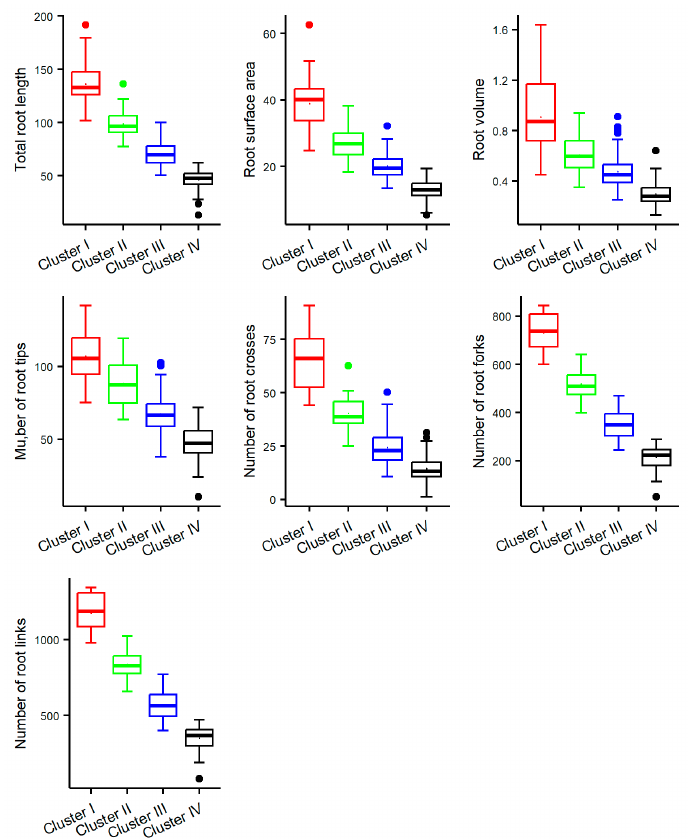
Figure 4. Boxplot for each of the variables with the average and standard difference of error values for each bean genotype cluster from the root phenotyping of ADP entries [34].